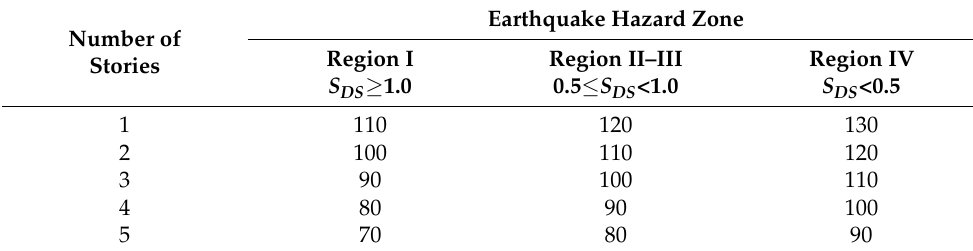
Table 6. Earthquake hazard zones and base score for masonry structures [16]. Number